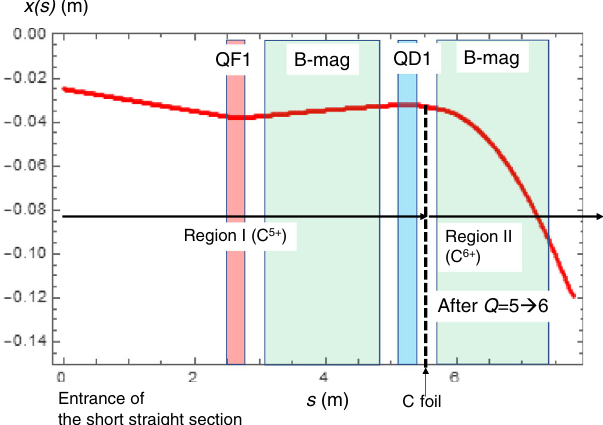
FIG. 6. Extraction orbits of a carbon ion with the momentum deviation of ð Δ p=p 0 Þ I ¼ − 1 % in region I; the last stage orbit in QF1 assumes a nominal gradient.